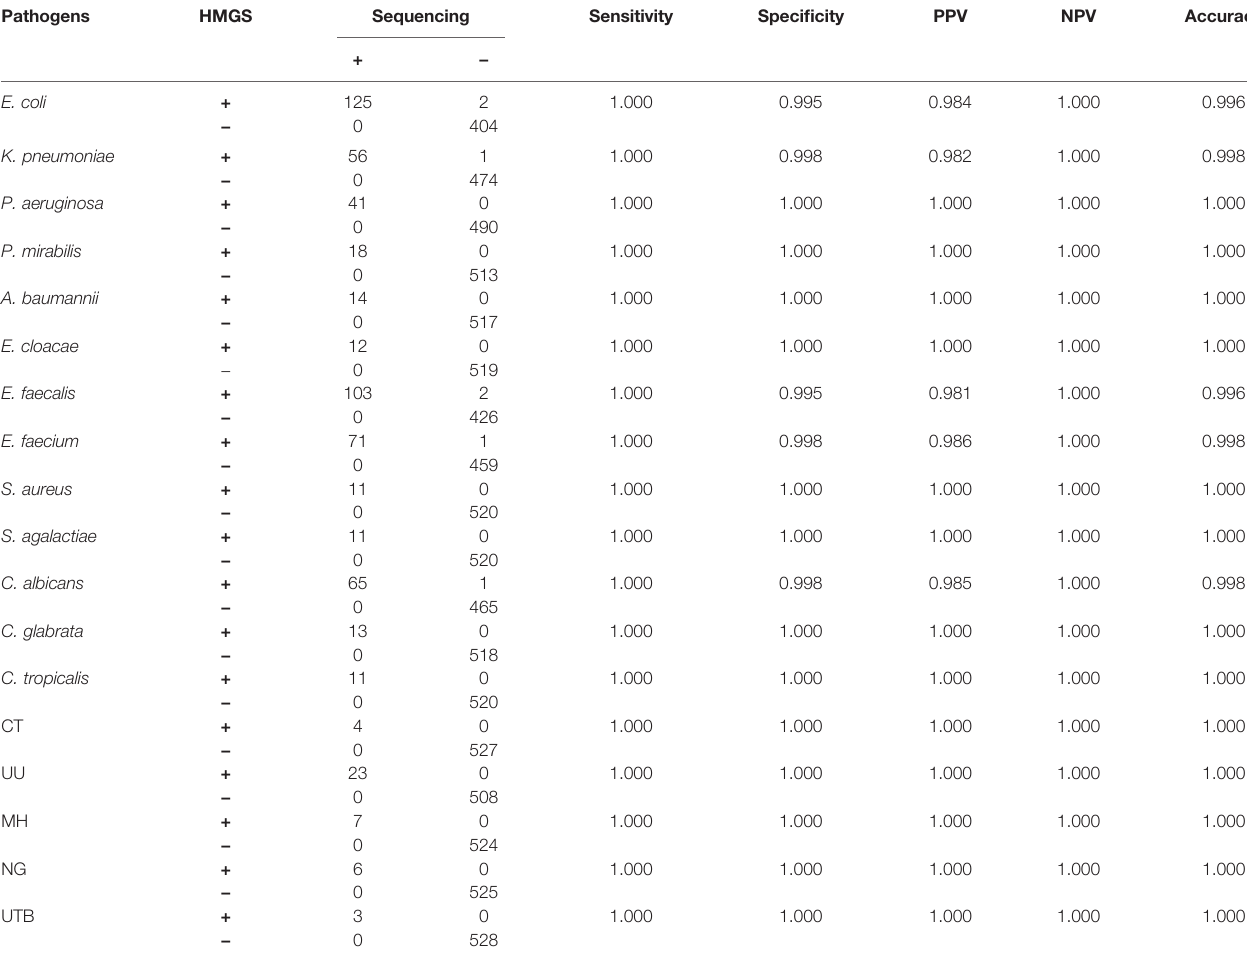
TABLE 2 | UTI-HMGS exhibited uniformly high sensitivity for the detection of uropathogens when compared to the Sanger sequencing method. Pathogens